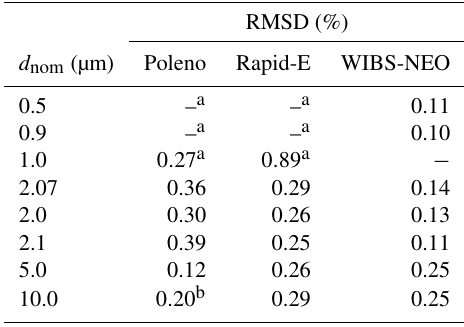
Table 3. Root mean square deviation (RMSD) between the scaled DUT and the scaled reference concentration measurements. Both time series where scaled by dividing with their own average before computing the